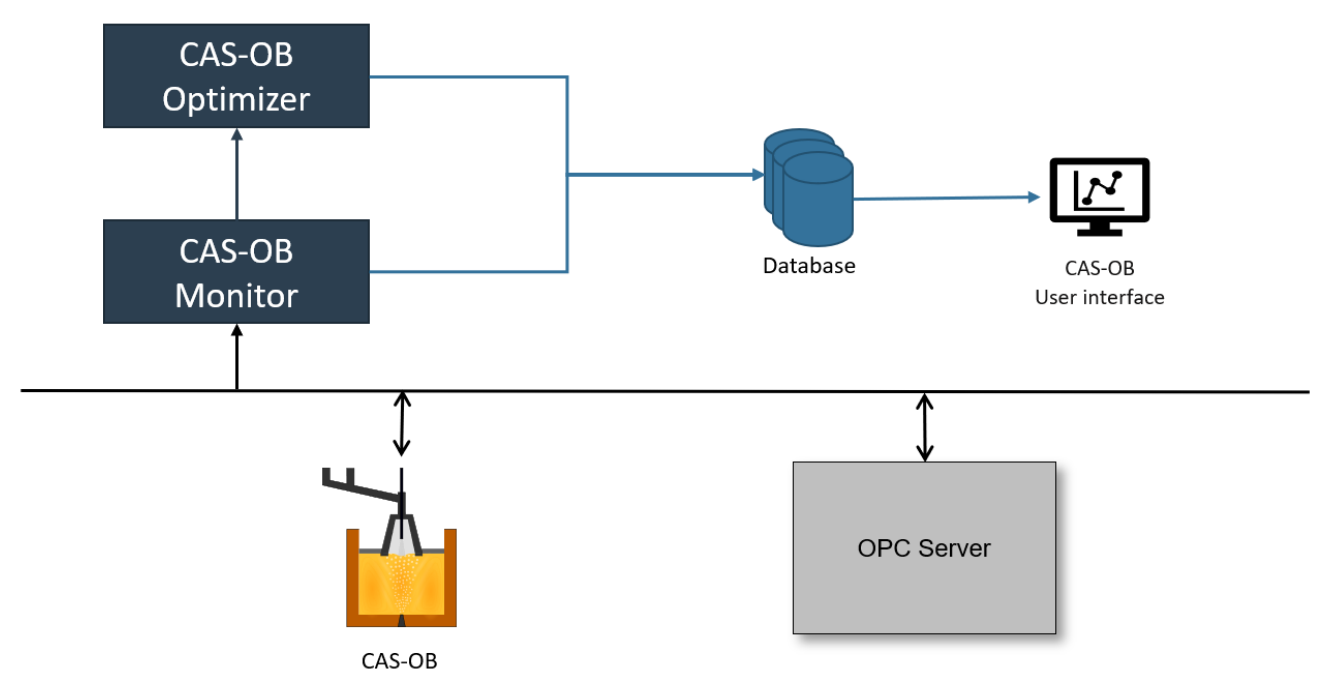
Figure 2. Real-time application configuration at